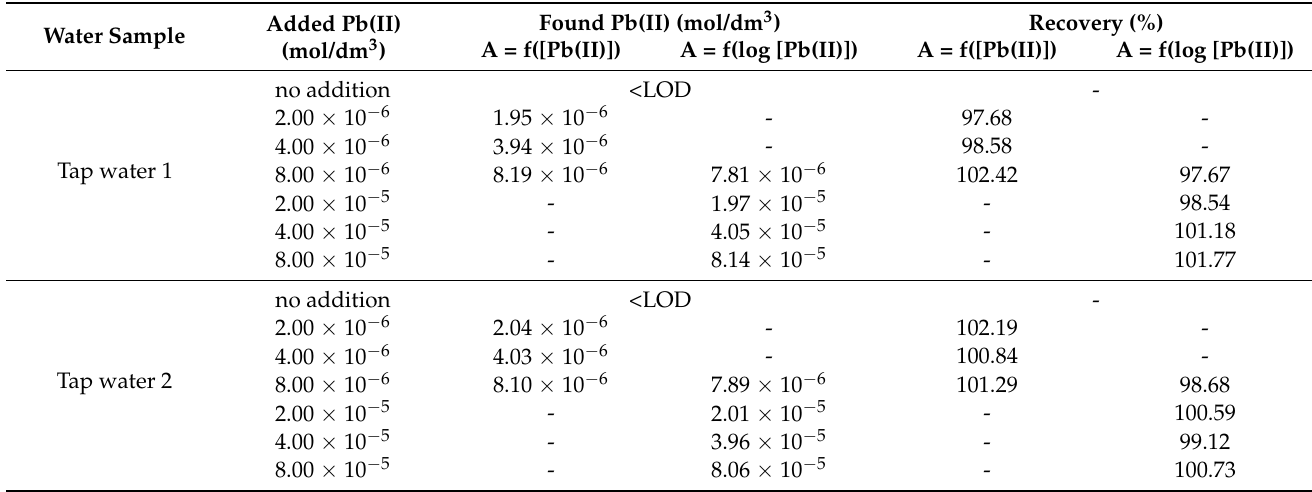
Table 2. Determination of lead(II) in spiked tap water samples using crown 3 as colorimetric probe. Water Sample